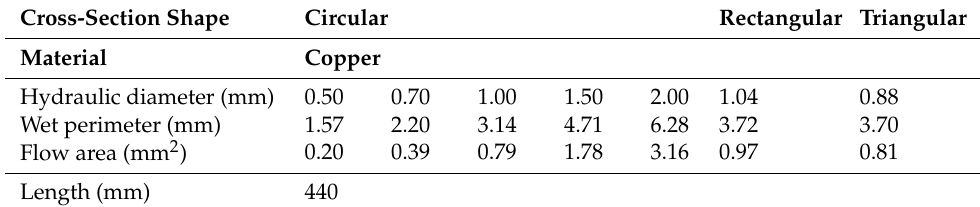
Figure 3. Cross-section shapes of test tubes. Table 1. Specifications of test tubes.